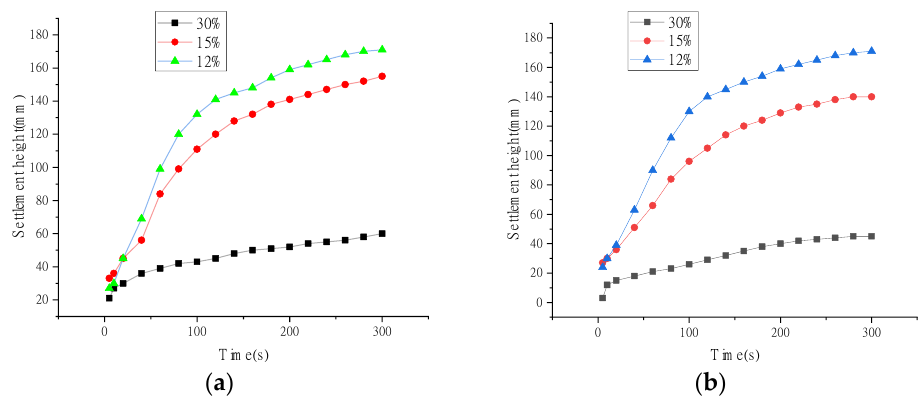
Figure 5. Different content tailings settlement experiment chart ( a ) The flocculant content is 50g/t and ( b ) The flocculant content is 60g/t.